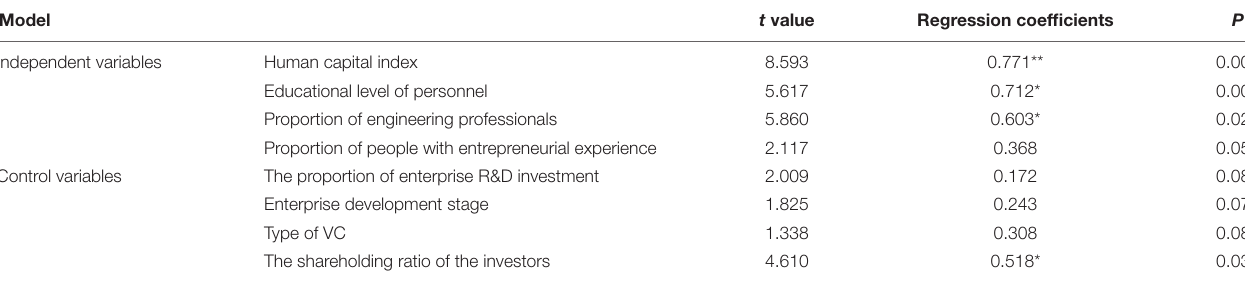
TABLE 3 | Regression analysis of the number of patents of invested enterprises and innovation ability of enterprises.